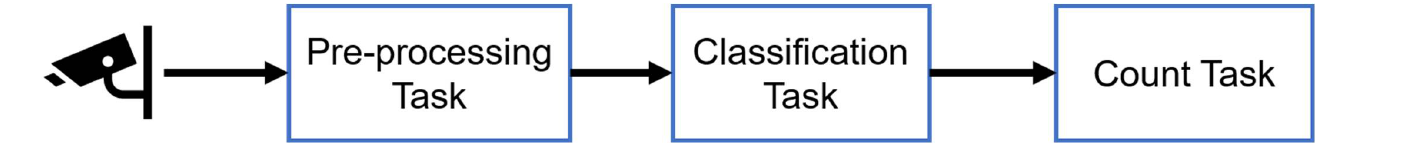
Figure 5. Passenger counting TS-IoT application tasks.